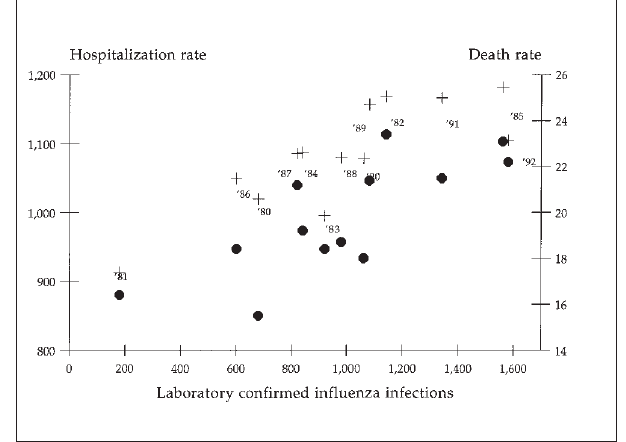
Figure 1) Laboratory-confirmed influenza infections and relations to pneumonia and influenza death rate, Canada, 1980 to 1992. Pneumo- nia and influenza deaths (International Classification of Diseases 9 480to487)per100,000populationaged65yearsandolderpermonth during the influenza season across Canada (four to eight months de- pending on the season)